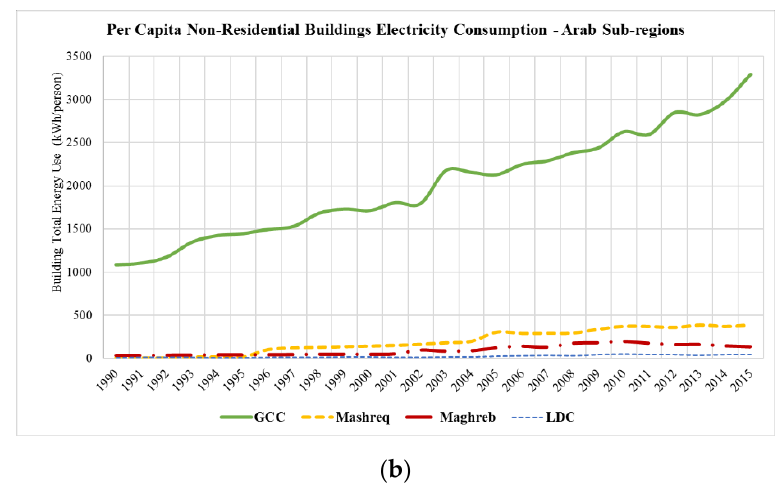
Figure 16. Annual per capita non-residential building ( a ) total energy consumption and ( b ) electricity consumption for the Arab sub-regions during the 1990–2015 period.